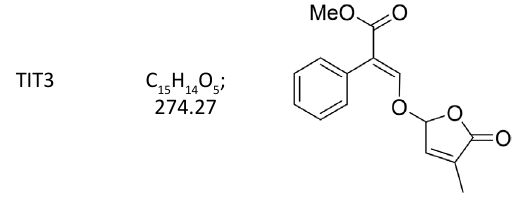
Fig. 1a. structure of TIT3 and its Molecular formula. Table 1. Bioassay of lethality test (mortality %) compounds Mortality % at different concentrations µg/ml.